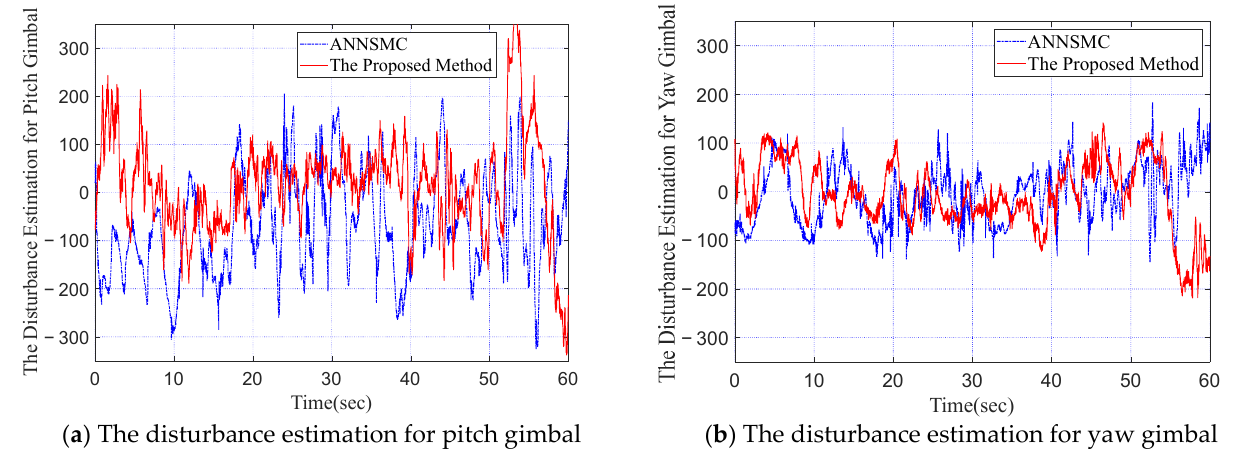
Figure 9. The control voltages of the two controllers in Case 1.